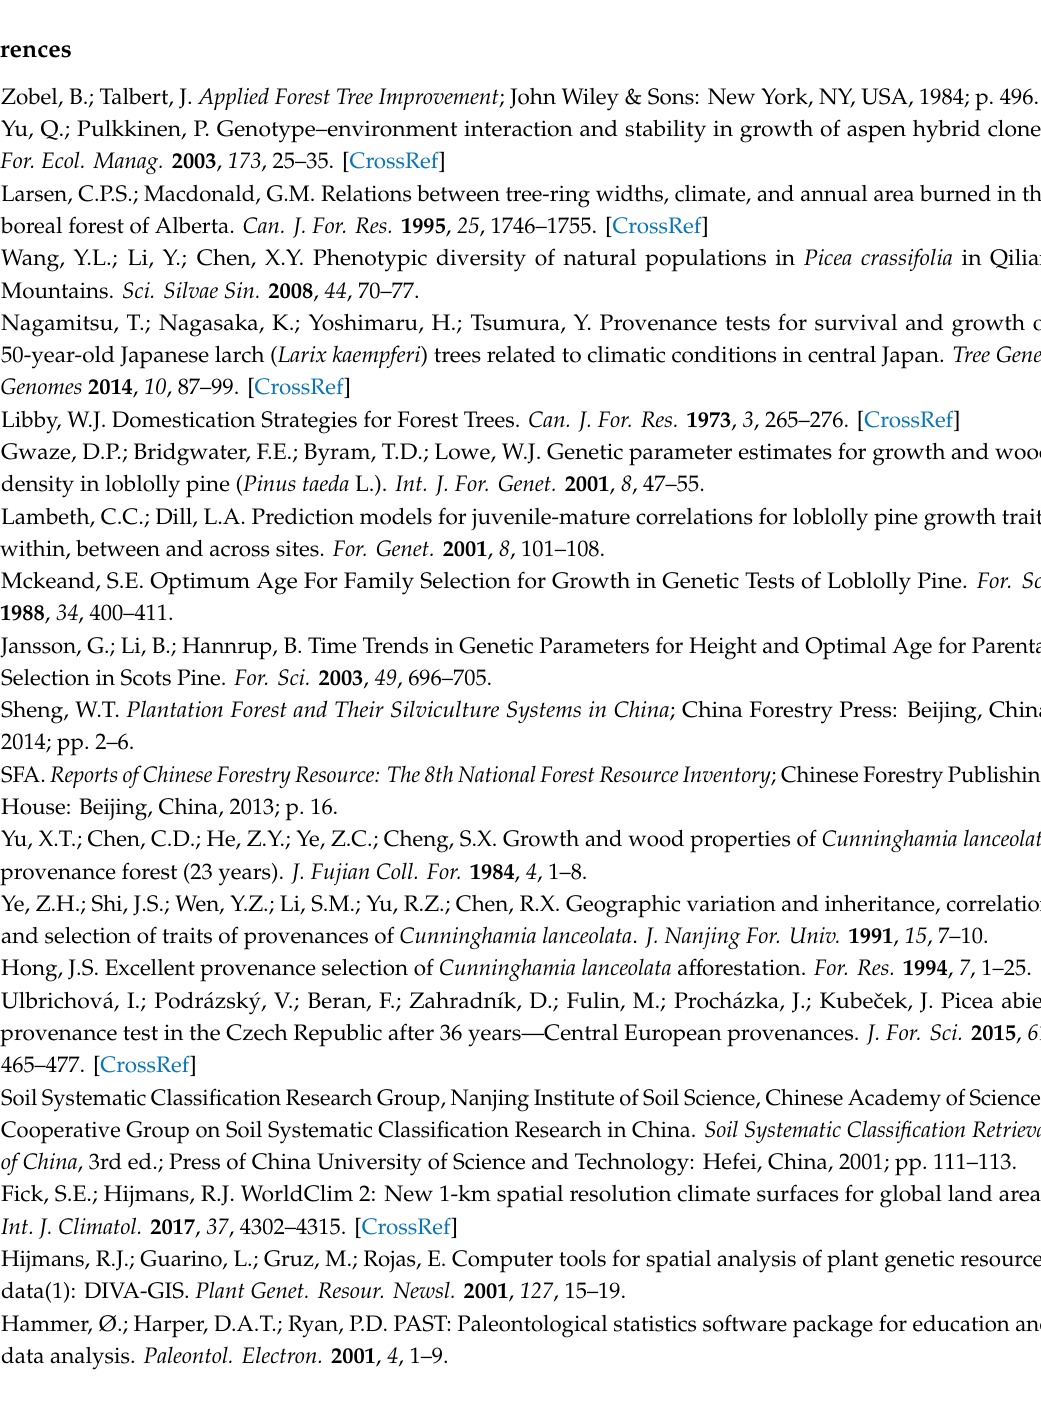
Table S1: Characteristics of the tested Chinese fir populations. The mean survival rates of 195 provenances were estimated at age of 33